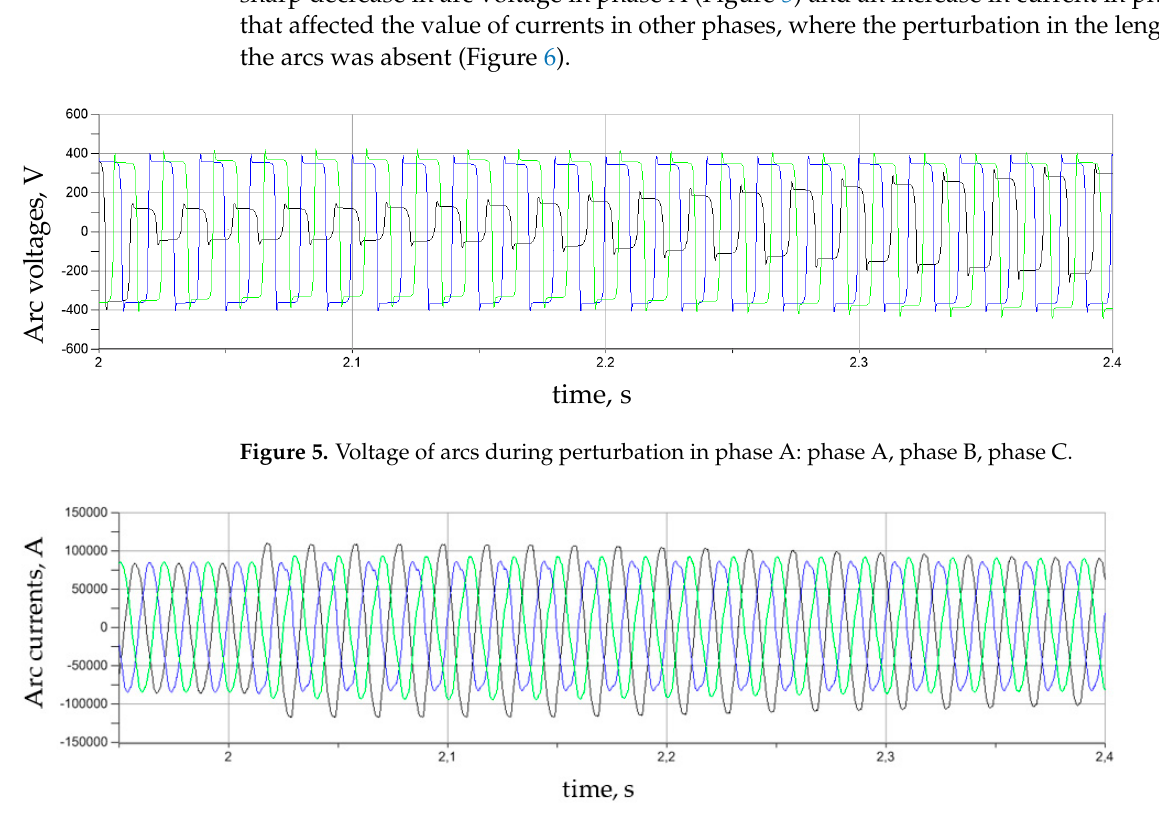
Figure 6. Currents of arcs during perturbation in phase A: phase A, phase B, phase C. Table 1. Comparison of the calculation results of arc currents with the results of the experiment: I A ,